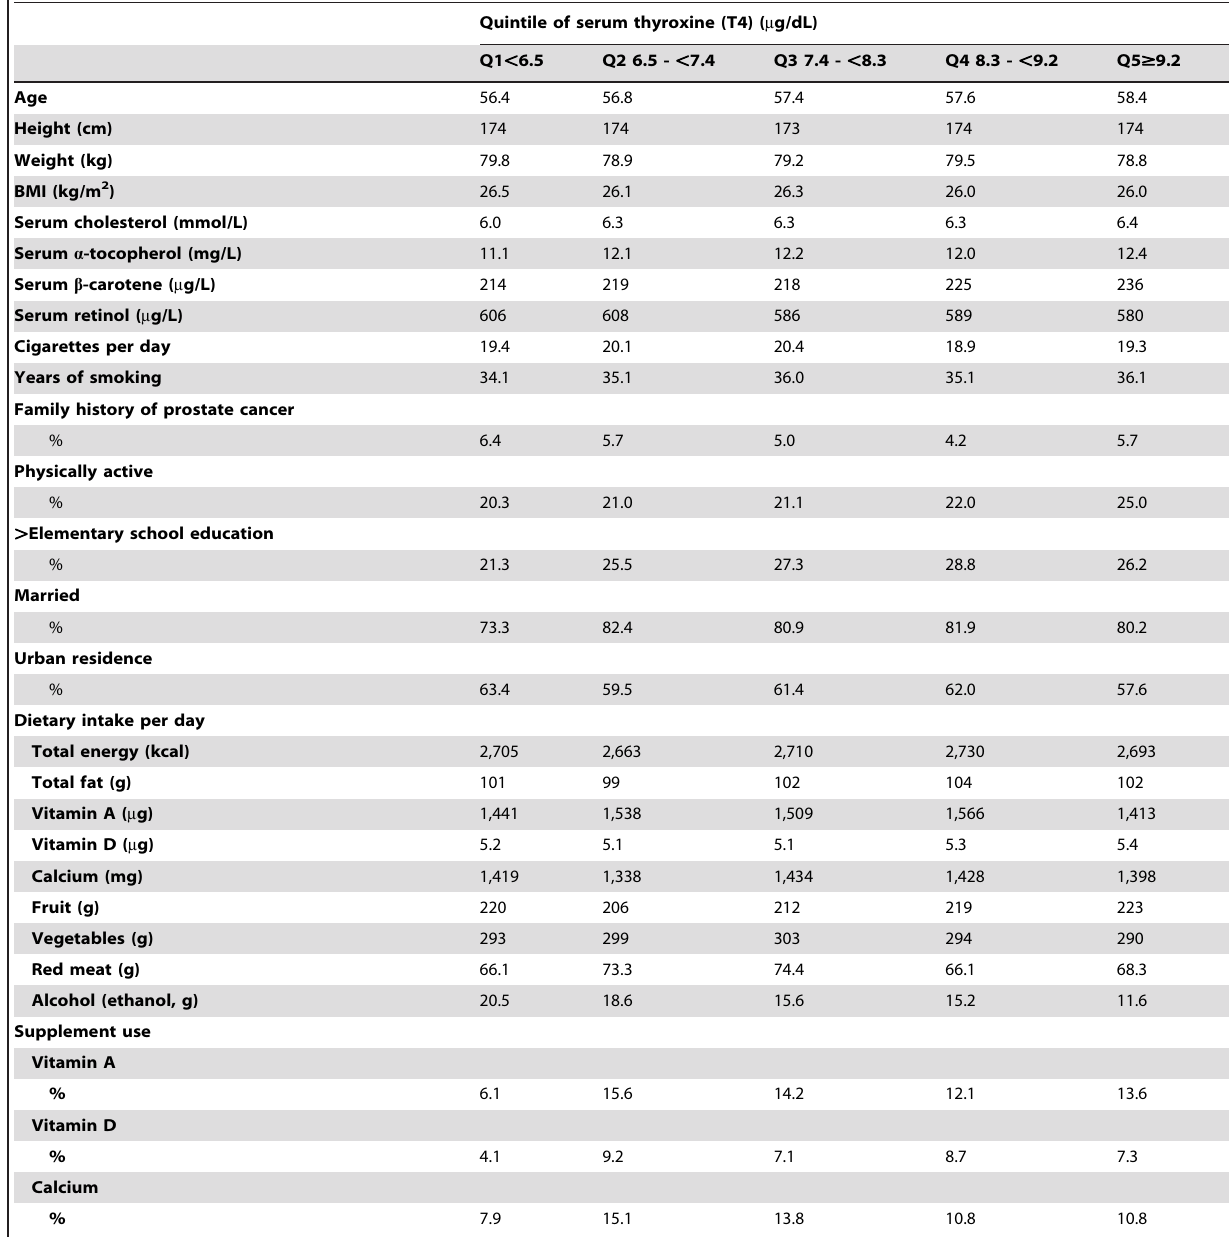
Table 2. Age-adjusted * baseline { characteristics by quintile of baseline serum thyroxine